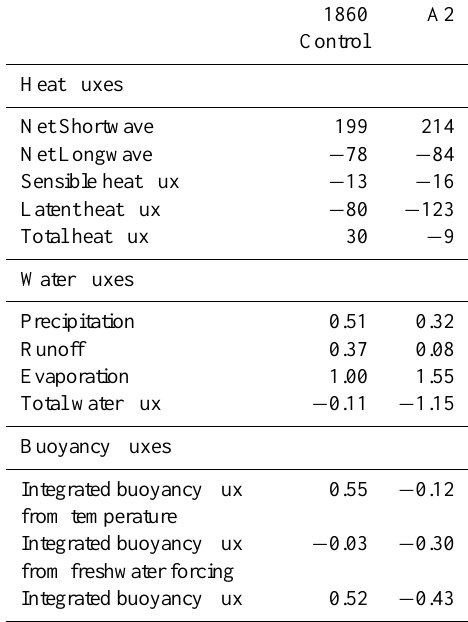
Table 3. Annual mean heat, annually integrated water, and an- nual integrated buoyancy fluxes off Central Chilean coast (76 ◦ W– 72 ◦ W, 39 ◦ S–33 ◦ S) for years 2281–2300 in the A2 run and 221– 240 in the 1860 Control run. Heat fluxes in Wm − 2 , water fluxes in m, and integrated buoyancy fluxes in m 2 s − 2